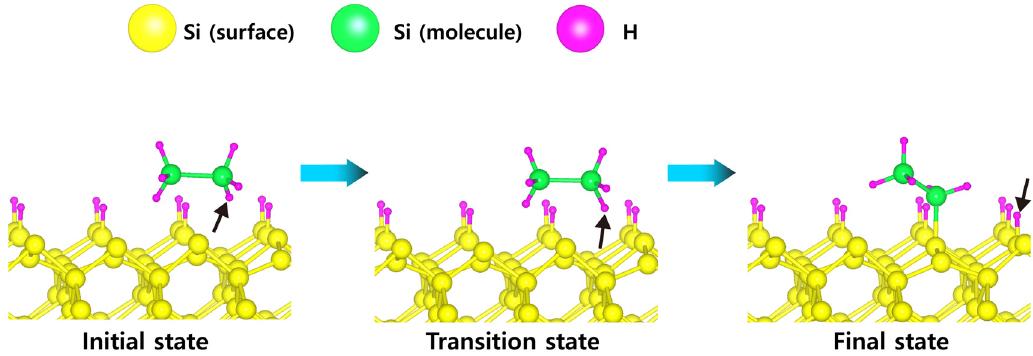
Figure 6. Optimized initial, transition and final structures for the first dissociative reaction step of a Si 2 H 6 molecule on the H-50% covered Si(001) surface.